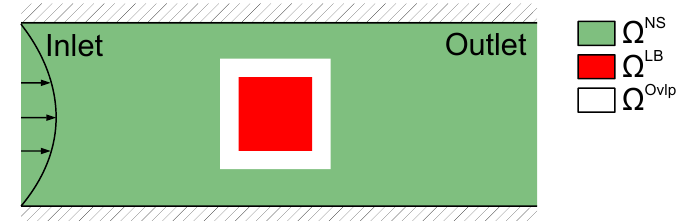
Figure 1. Decomposition of the computational domain into subdomains Ω NS and Ω LB for the NS and LB solver, and an overlap region Ω Ovlp .